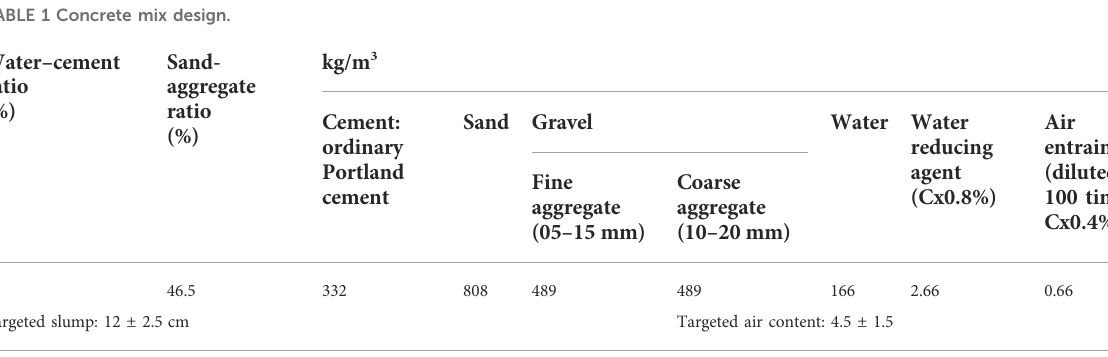
TABLE 1 Concrete mix design.